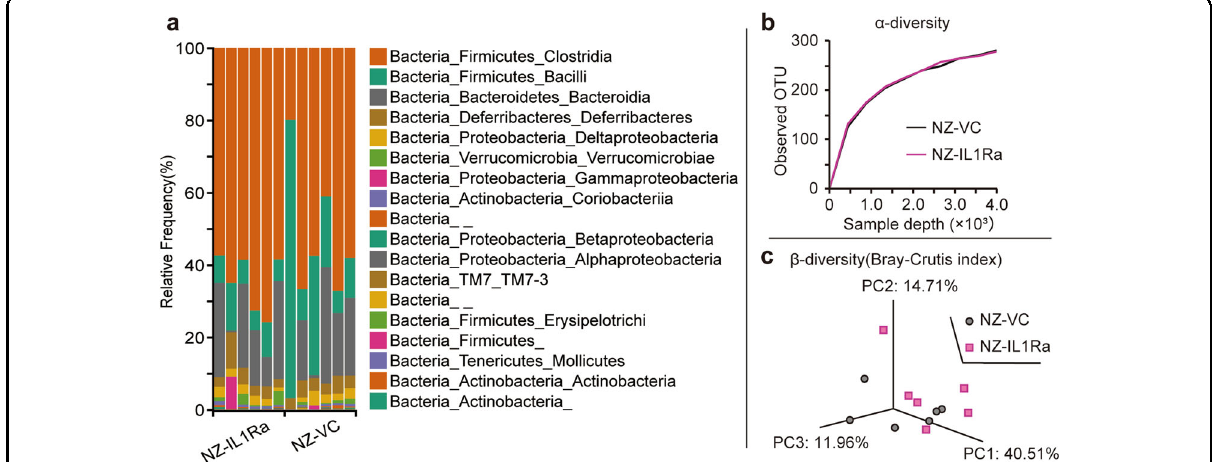
Fig. 7 Effects of NZ-IL1Ra on the cecal microbiota. a The cecal microbiota composition in the NZ-IL1Ra and NZ – VC groups ( n = 6). The V3 – V4 region of 16S rRNA from cecal contents was ampli fi ed and sequenced. The resulting sequences were analyzed using the QIIME2 pipeline and classi fi ed using the Greengenes database. b α -Diversity (the rarefaction curve of observed OTUs) in the NZ-IL1Ra and NZ – VC groups ( n = 6). c β -Diversity (the Bray – Curtis index) in each group ( n = 6).